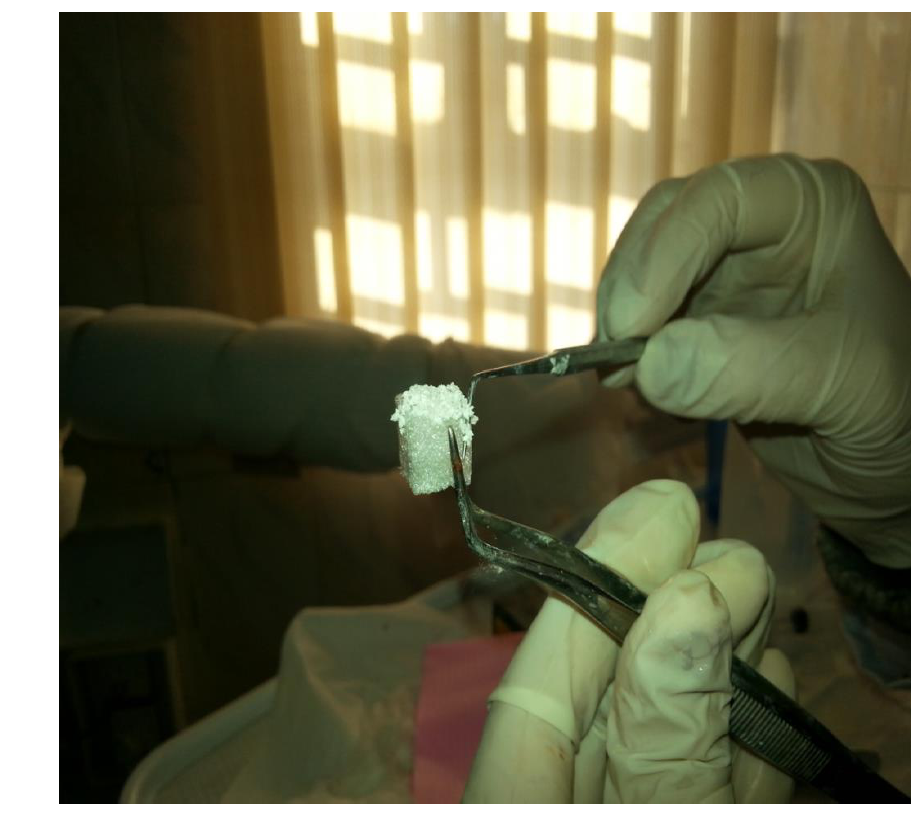
Figure (2): The collagen sponge with the bone